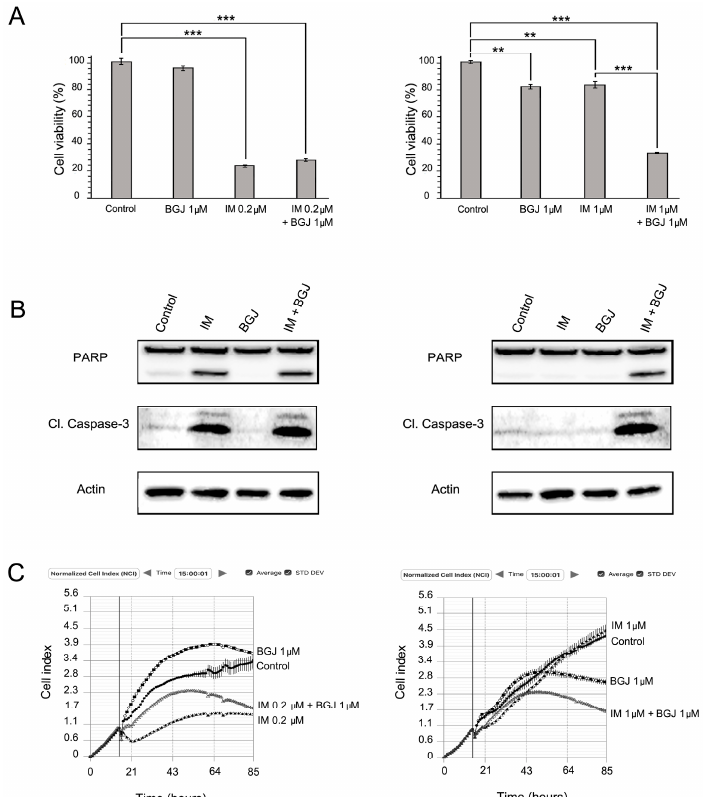
Figure 4. FGFR inhibition induces apoptosis and enhances cytotoxic effects of IM in IM-resistant GIST cells. ( A ) Effects of FGFR inhibition on the viability of GIST T-1 and T-1R cell lines. Cells were treated with DMSO (control), FGFR inhibitor (BGJ398), IM alone and in combination and analyzed using the MTS-based assay after 48 h. Data of triplicates are represented as the mean ± SD. **: p ≤ 0.01; ***: p ≤ 0.001; ( B ) Immunoblot analysis for apoptosis markers (cleaved forms of PARP and caspase-3) in GIST cells after treatment with DMSO (negative control), BGJ398 or IM alone and in combination for 72 h. Actin stain used as a loading control; ( C ) Changes in growth kinetics of GIST T-1 (left) and GIST T-1R (right) cells treated with DMSO (control), IM or BGJ398 alone and in combination.